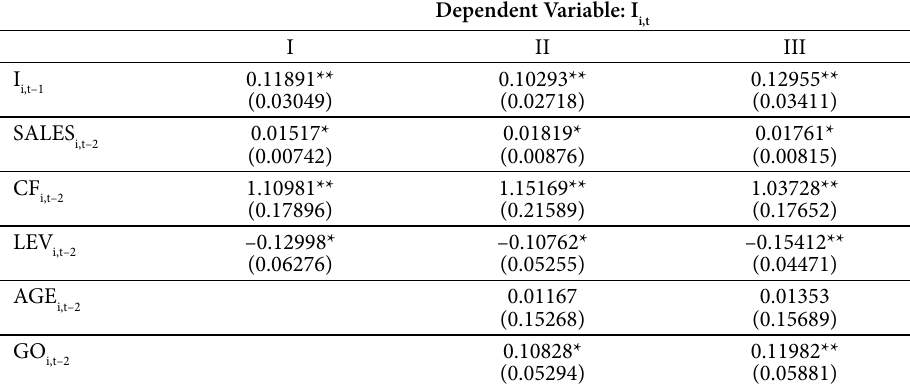
Table B1. investment determinants of fitness sMEs – alternative measure of dependent variable, lagged explanatory variables and ols